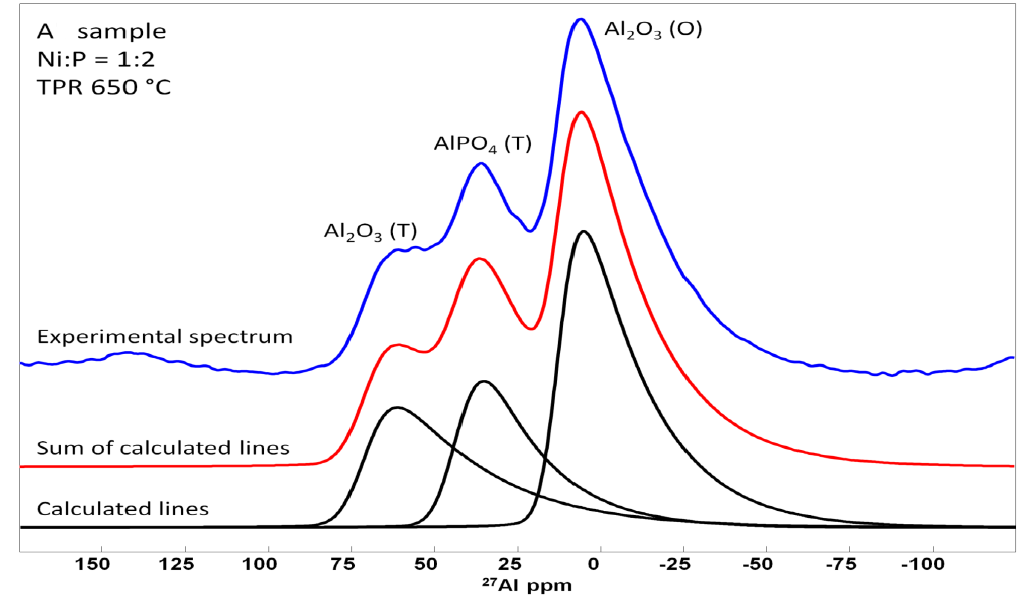
Figure 7. Blue–experimental 14 kHz MAS 27 Al NMR spectrum of NiP_A/Al 2 O 3 (650) sample, black–theoretic calculated lines corresponding to different Al 2 O 3 and AlPO 4 sites, red–sum of the calculated lines.